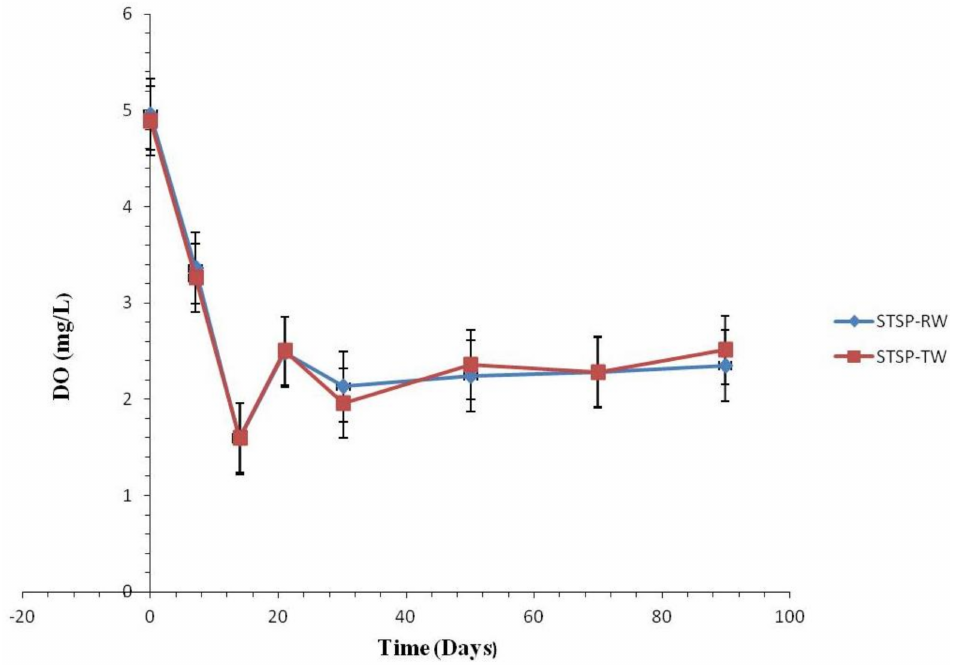
Figure 2. Variations of dissolved oxygen concentration in RW and TW in stainless steel pipes against time with standard error